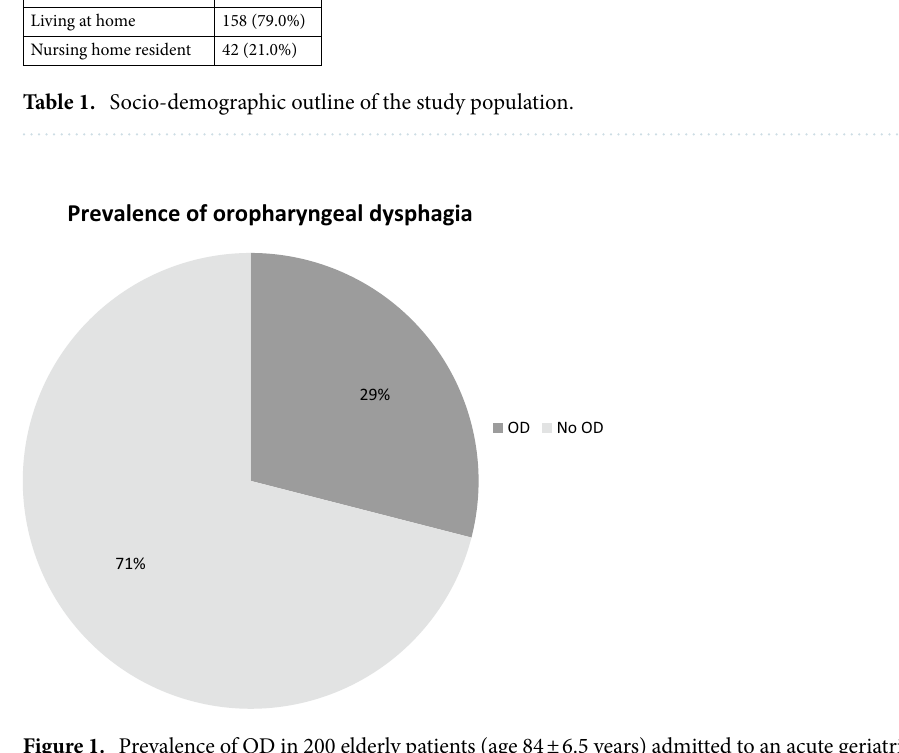
Figure 1. Prevalence of OD in 200 elderly patients (age 84 ± 6.5 years) admitted to an acute geriatric hospital 17